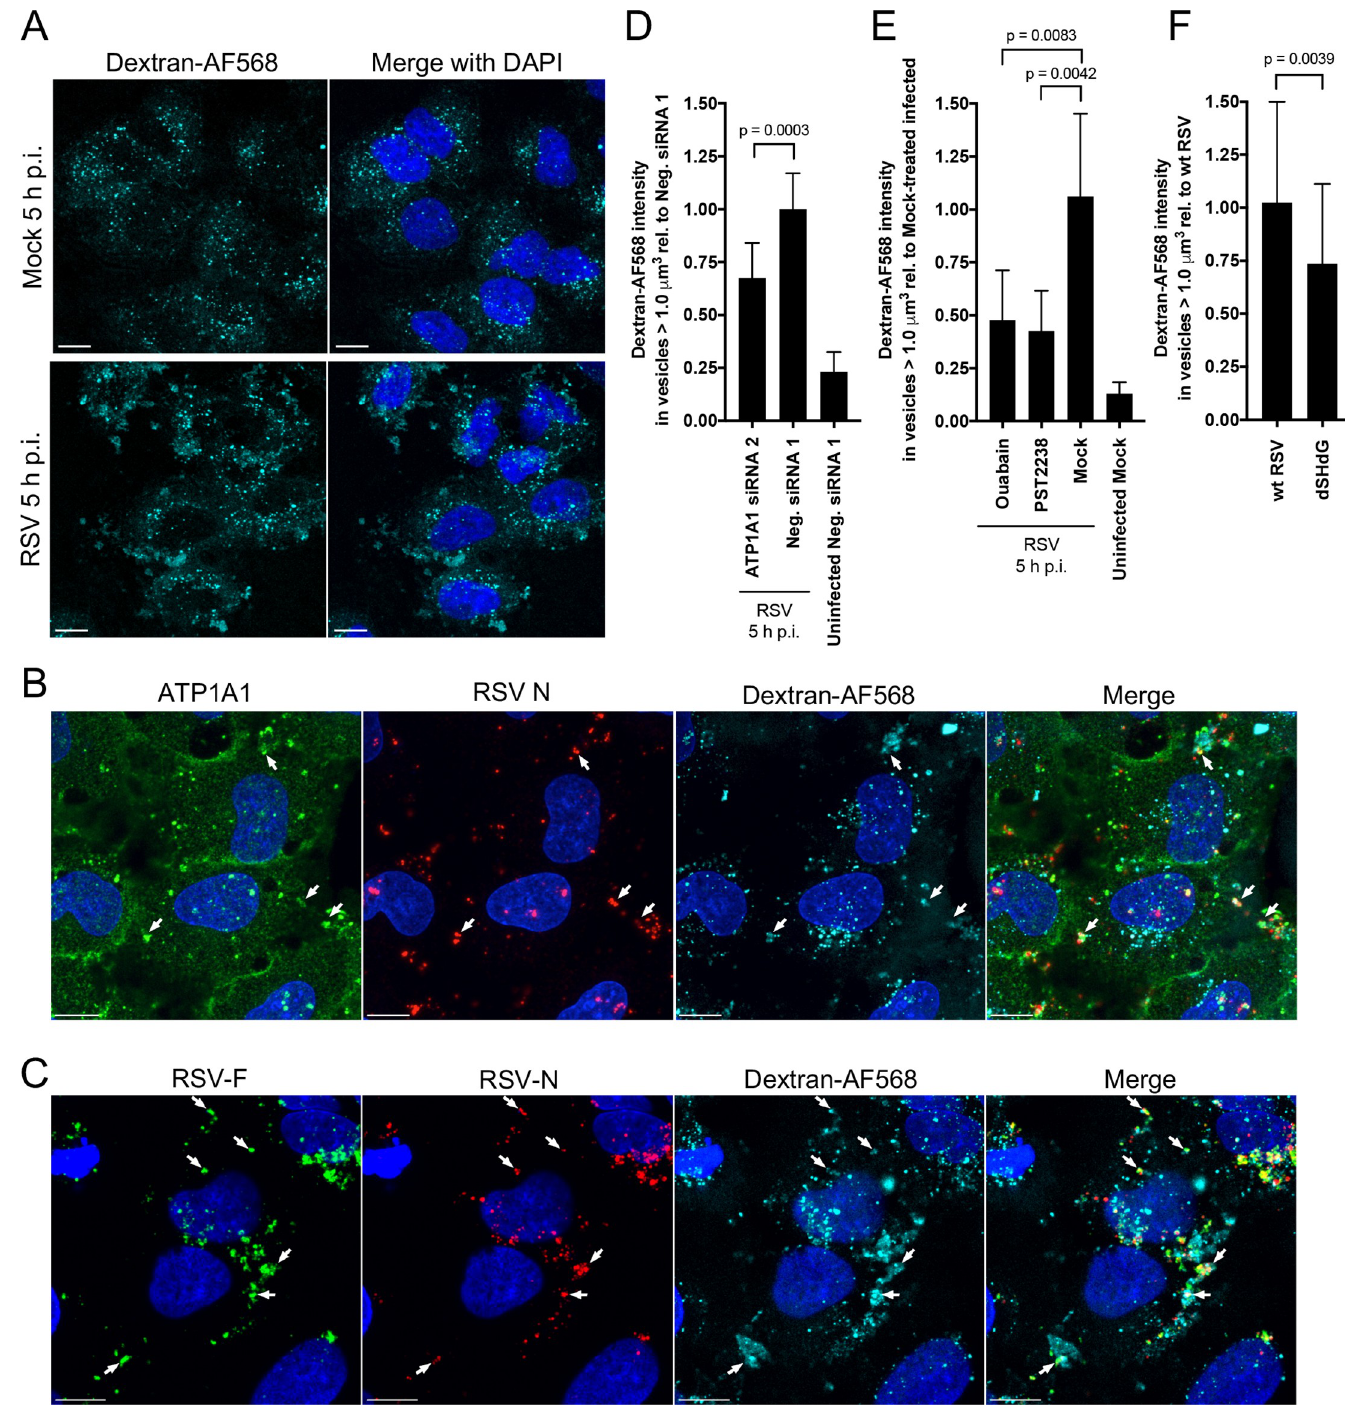
Fig 9. RSV induces and is taken up by ATP1A1-dependent macropinocytosis, which can be blocked by ouabain or PST2238. Macropinocytosis was assayed by monitoring the uptake of dextran (10,000 MW) conjugated to AF568 (dextran-AF568). All incubations with dextran-AF568 were preceded by serum-starvation for 16 h. (A) RSV induces macropinocytosis. A549 cells were mock-infected or infected with wt RSV (MOI = 5 PFU/cell) in medium containing dextran-AF568 (cyan). At 5 h p. i., cells were fixed with 4% PFA and nuclei counterstained with DAPI (blue), and imaged on a Leica SP5 confocal microscope with a 40x Objective NA 1.3 and 2.0x zoom. (B) Co-localization of ATP1A1, RSV N, and dextran-AF568 in RSV-infected A549 cells . Cells were infected with RSV in the presence of dextran-AF568 as described above, incubated for 5 h, fixed with 4% PFA, permeabilized with 0.1% Triton X-100, subjected to immunofluorescence staining with an anti-ATP1A1 rabbit MAb (ab76020) and an anti-RSV-N mouse MAb (ab94806), followed by AF488-conjugated goat anti-rabbit and AF647-conjugated goat anti-mouse